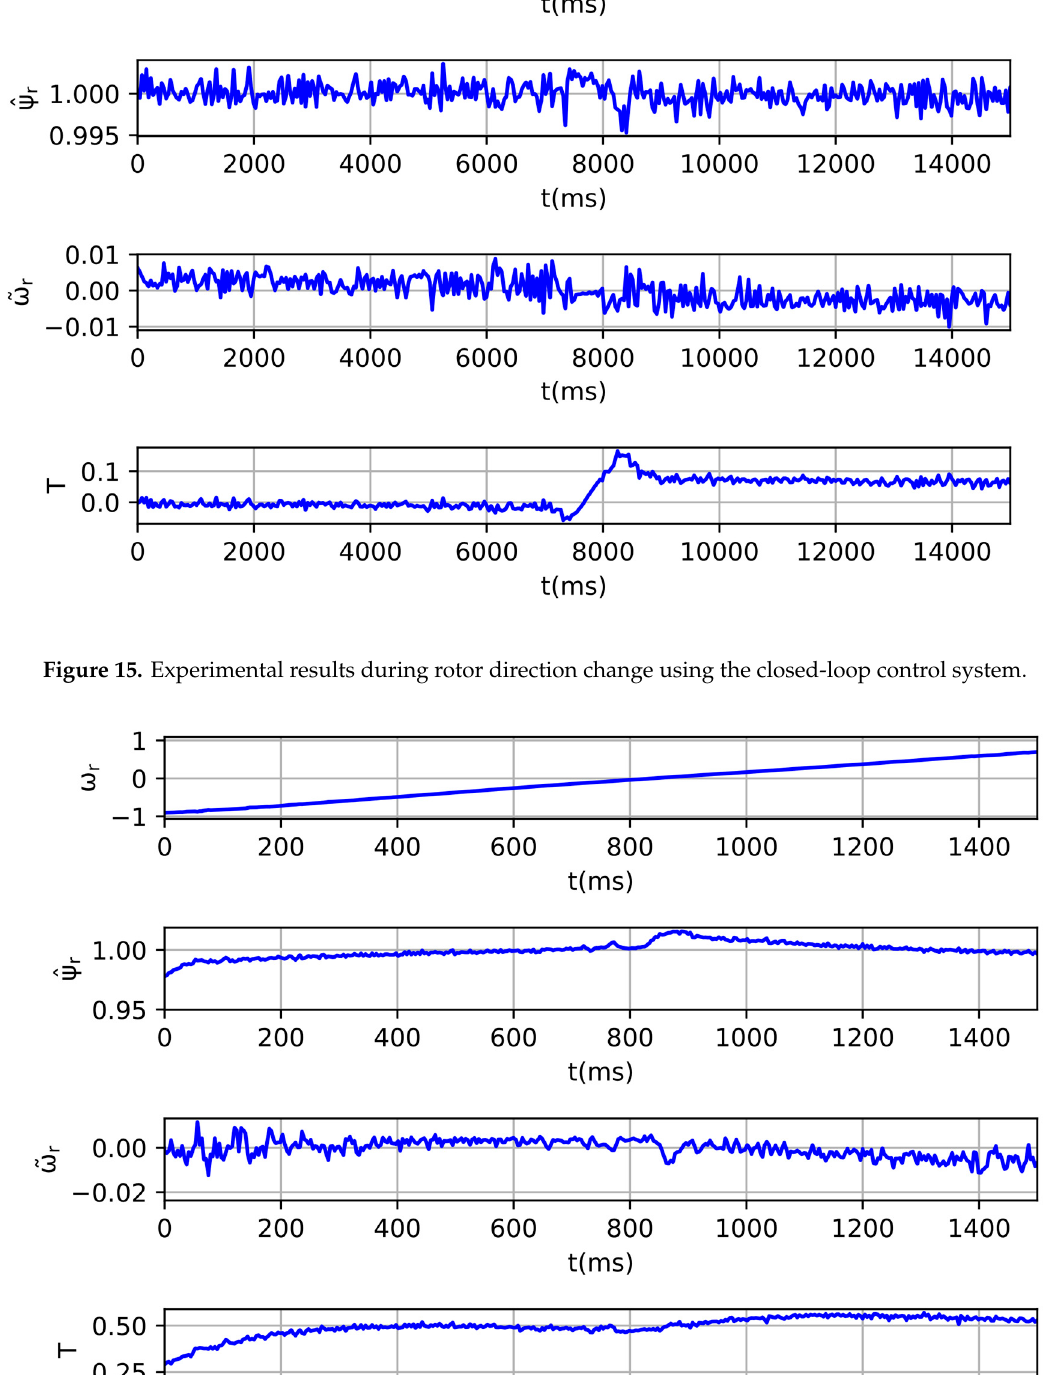
Figure 16. Experimental results during fast rotor direction change using the closed-loop control system.